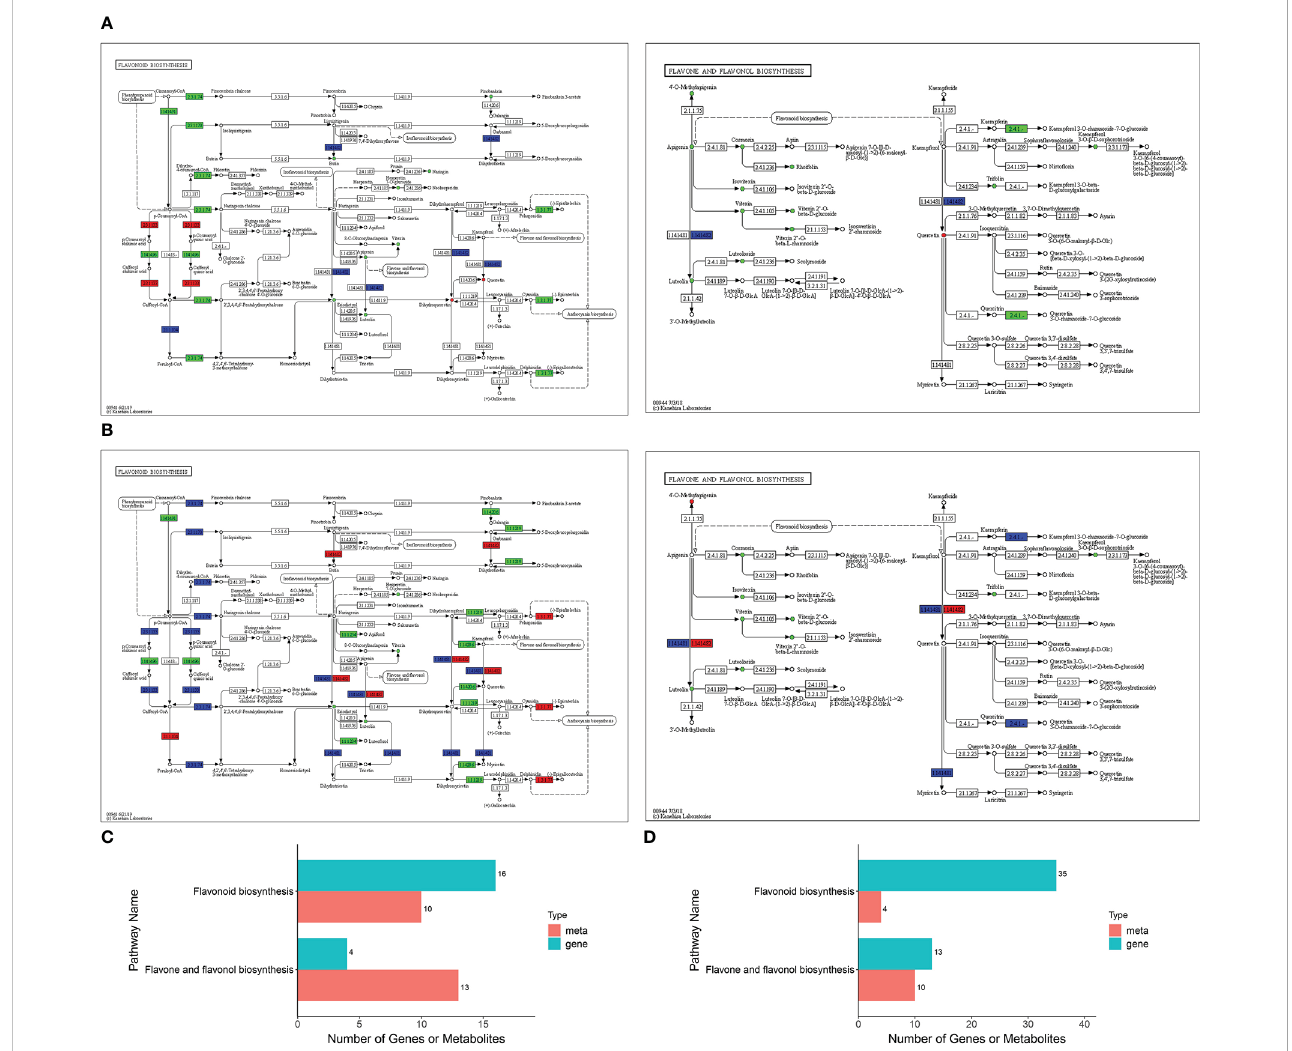
FIGURE 3 Integrated analyses of the identi fi ed differentially expressed genes and differentially accumulated fl avonoids. KEGG enriched pathways for (A) JM229-pm/ JM229-0 and (B) HHG46-pm/HHG46-0. Number of identi fi ed genes and metabolites involved in these KEGG pathways for (C) JM229-pm/JM229-0 and (D) HHG46-pm/HHG46-0. KEGG, Kyoto Encyclopedia of Genes and Genomes; meta,